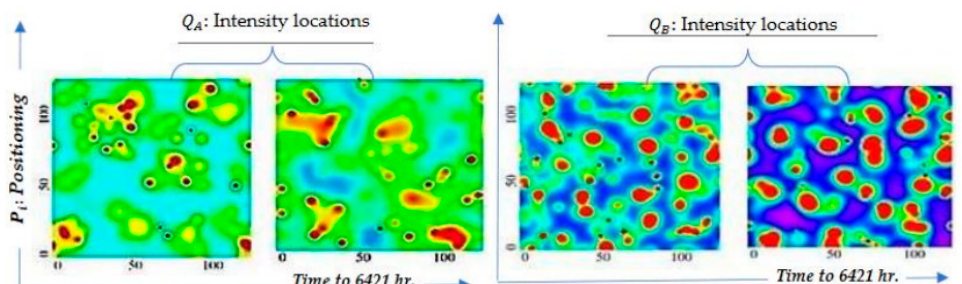
Figure 19. The intake (Al-Fe) and the exhaust (Al-Cu) gaskets’ conductors before failure. Figure 19. (A) The intake (Al-Fe) and the exhaust (Al-Cu) gaskets’ conductors before failure.